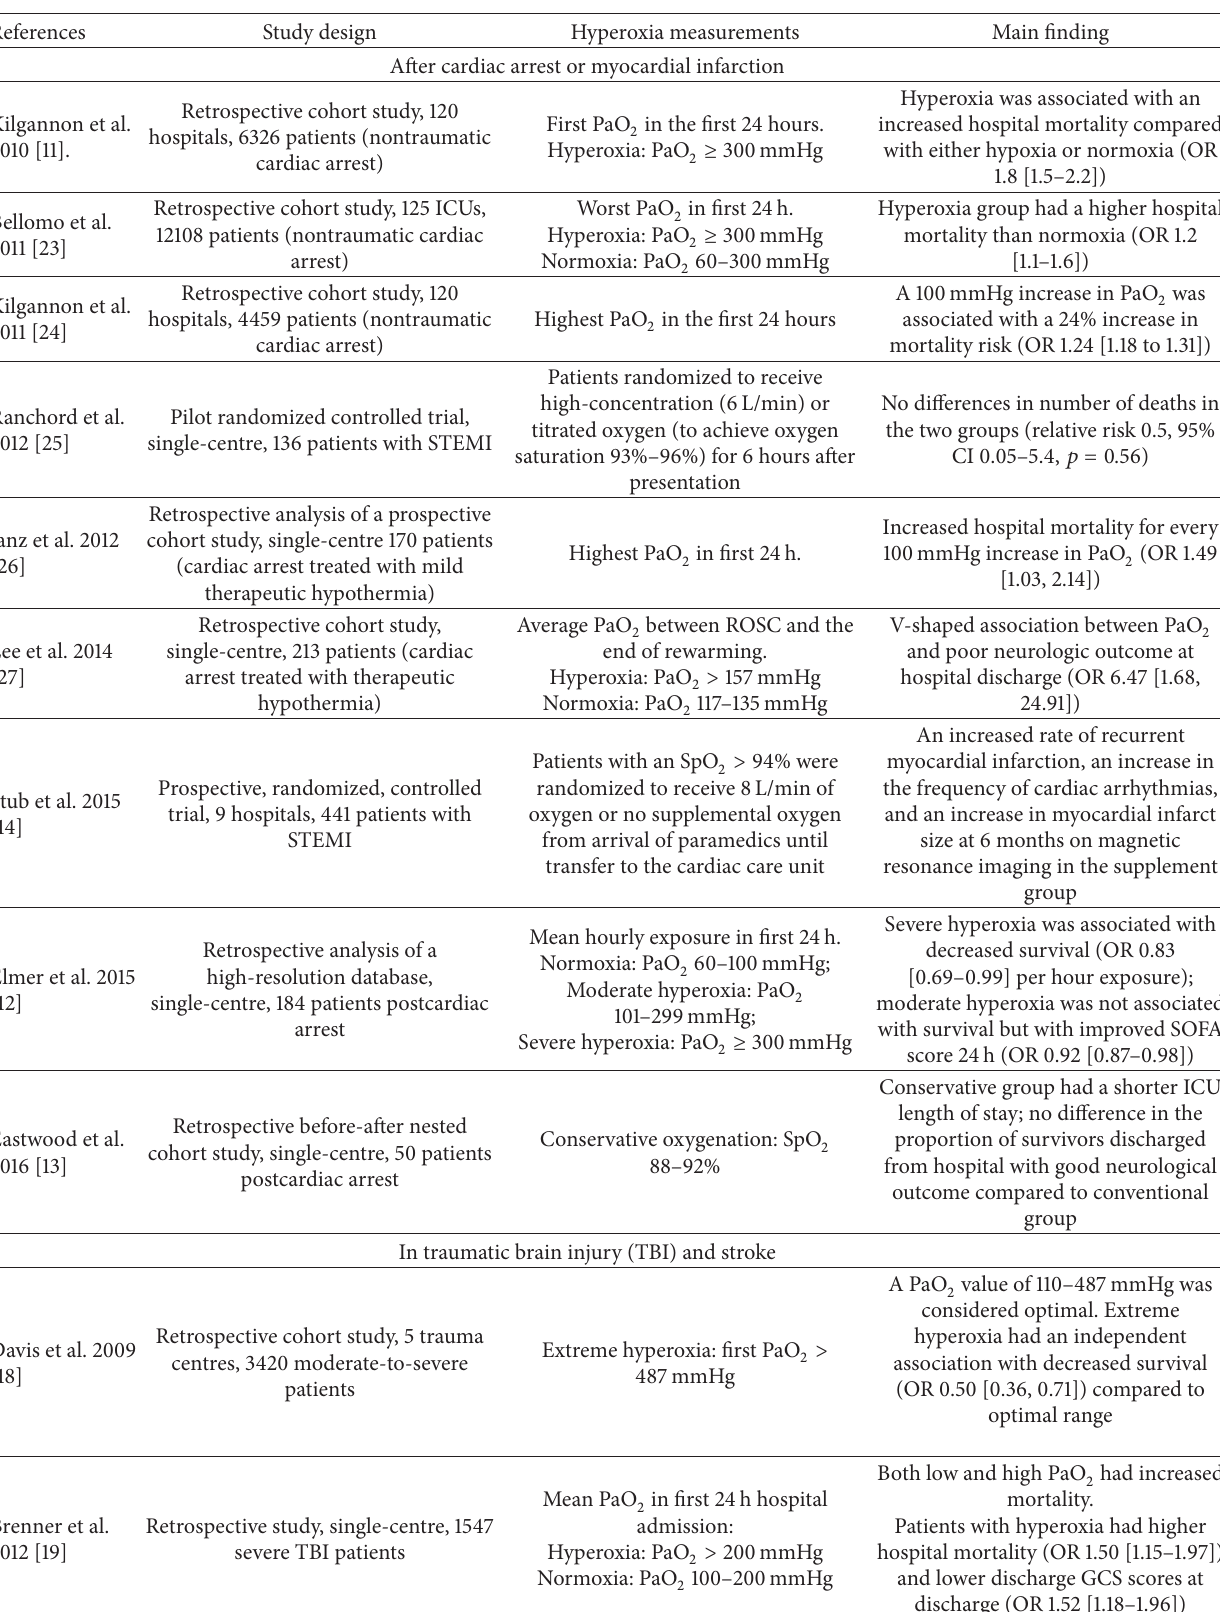
Table 1: Some recent clinical studies on the risks of hyperoxia after cardiac arrest or myocardial infarction, in traumatic brain injury, stroke, sepsis, and mixed ICU